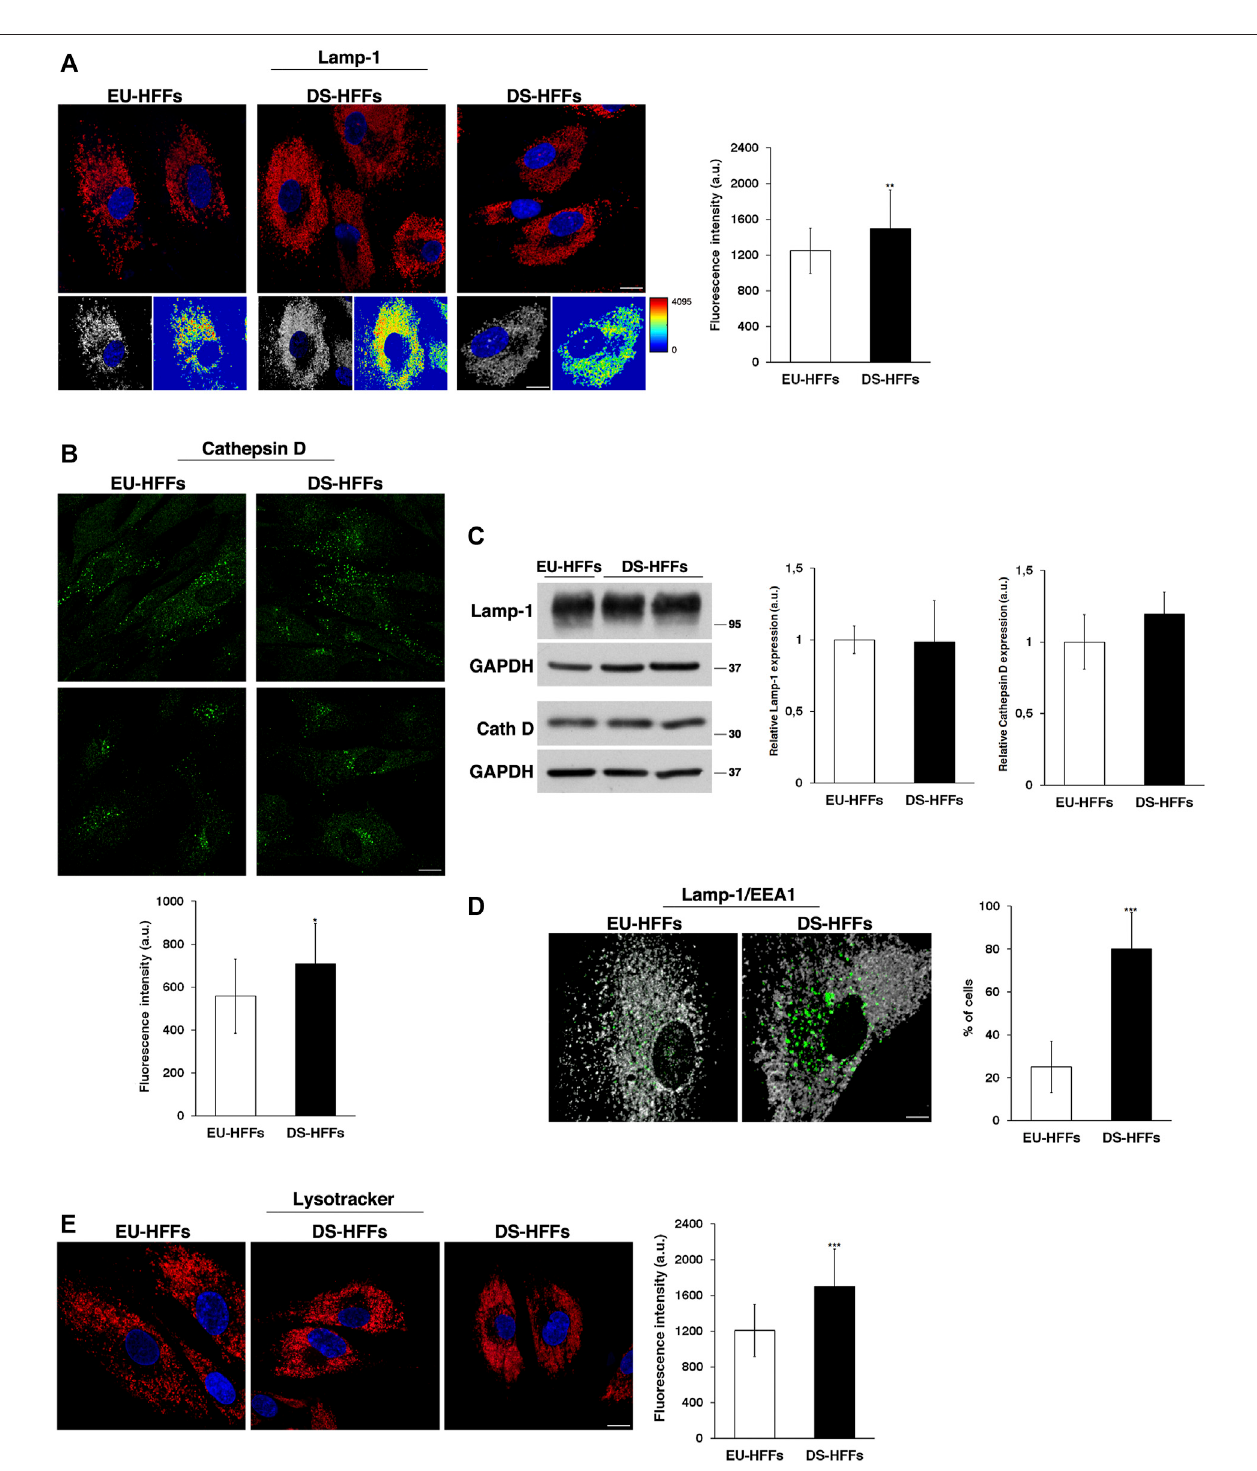
FIGURE 8 | The structure and distribution of lysosomes are perturbed in DS-HFFs. (A,B) Immuno fl uorescence assays using Lamp-1 (A) and Cathepsin D (B) antibodies inEU-HFFs and DS-HFFsareshown. Serial confocal sections were collected fromthe top tothebottom ofthe cells; scalebars, 8 μ m. The 3Dreconstruction andcorrespondingintensitymapareshownforLamp-1staining.Mean fl uorescenceintensity(arbitraryunit,a.u.)isshown.Thebarsshowtherelativemeanvalue±SDof three independent experiments, n ≥ 50 cells. (C) Representative immunoblotting of Lamp-1 and Cathepsin D in DS-HFFs and EU-HFFs (longer exposure of the immunoblot is shown in Supplementary Figure S3 ). GAPDH was used as the loading control. The molecular weight of protein markers is indicated. Densitometric analysis of three different experiments is shown. (D) Double immunostaining of Lamp-1 and EEA1 in EU-HFFs and DS-HFFs is shown; scale bar, 8 μ m. Representative